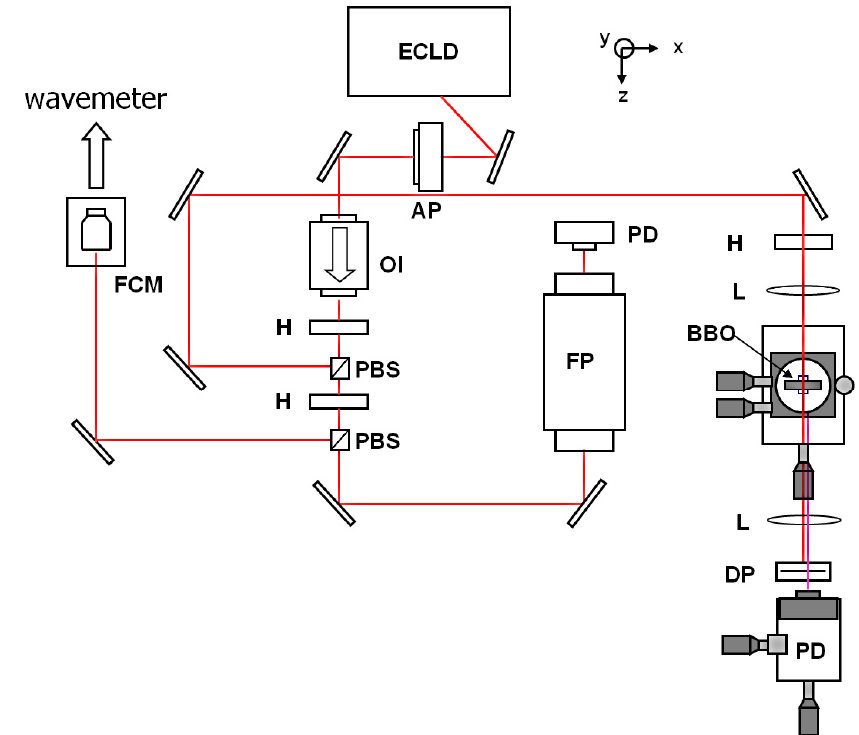
Fig. 3. (Color online) Experimental setup used for the measurement of the SHG conversion efficency according to the waist size. AP: Anamorphic prism, BBO: β -BaB 2 O 4 crystal, ECLD: Extended cavity laser diode, DP: Dichroic waveplate, FCM: three axis fiber coupling mount, FP: Fabry P´erot cavity, H: Half-waveplate, L: Lens, M: mirrors, OI: Optical isolator, PBS: Polarization beamsplitter, PD: Photodiode.